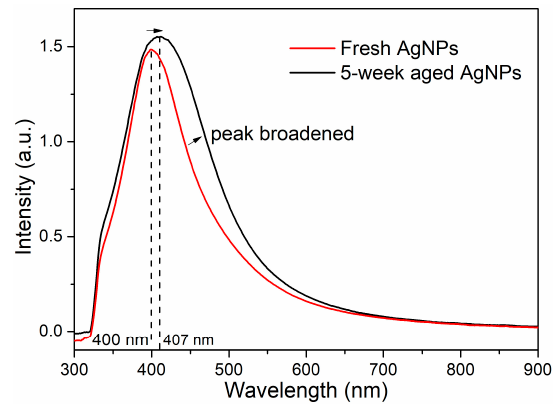
Figure 11. Absorption spectra for Ag NPs synthesized by ns laser ablation of Ag in acetone and then stored for five weeks.